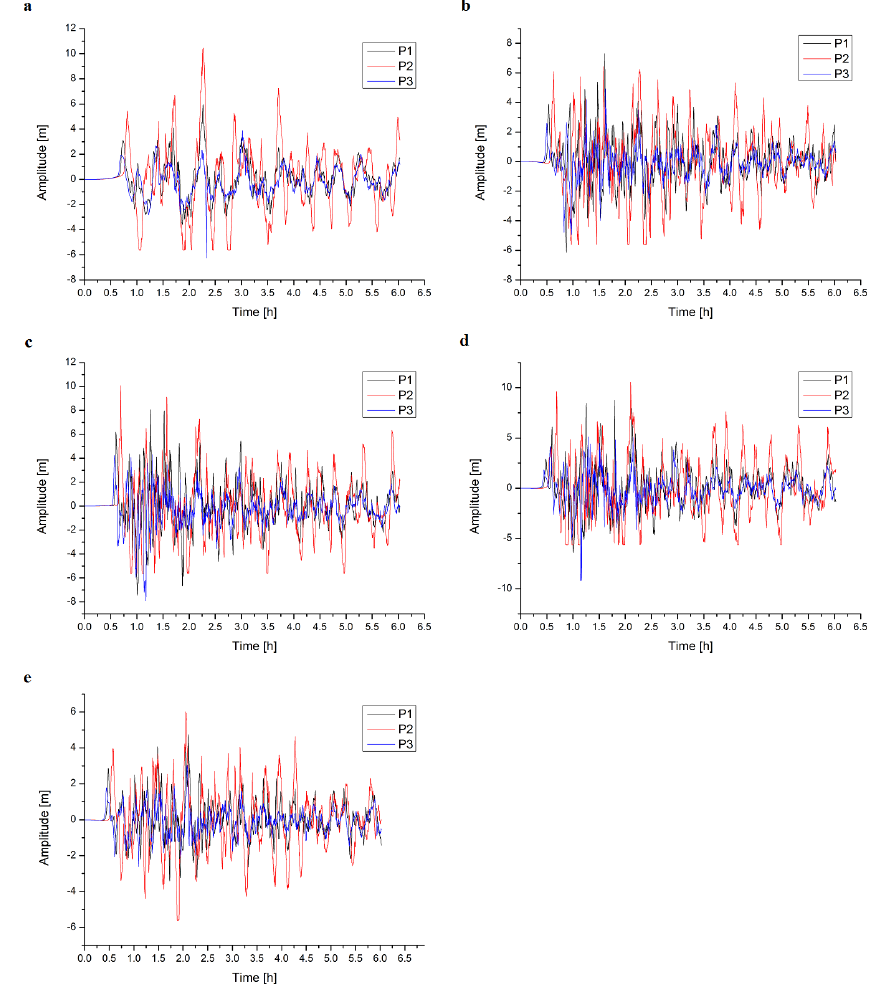
Figure 4. Synthetic waveforms for 6h propagation time at three chosen points (cf. Fig. 2) for the SWIM scenarios: (a) CWF; (b) GBF; (c) HSF; (d) HSMPF; (e) MPF.